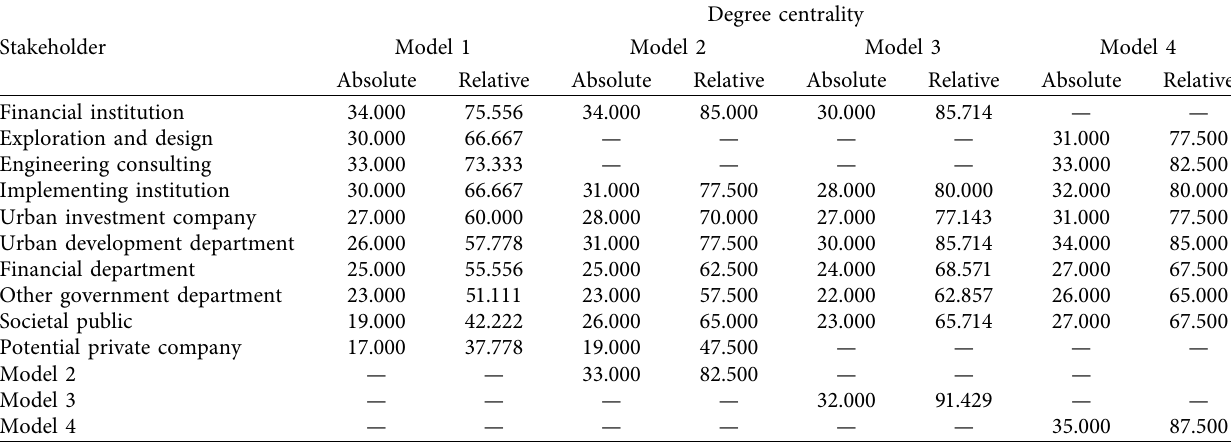
Table 8: Index of degree centrality.